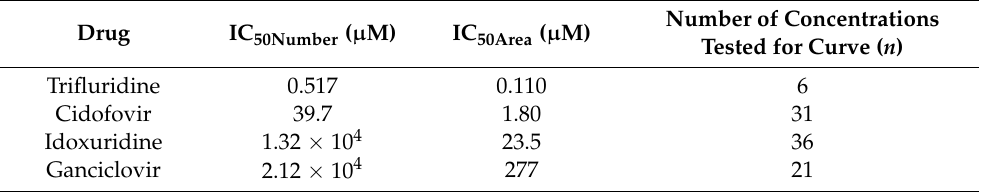
Table 1. Half-maximal inhibitory concentrations for nucleoside analogue antiviral agents against BoHV-1, determined using curve fit calculation.